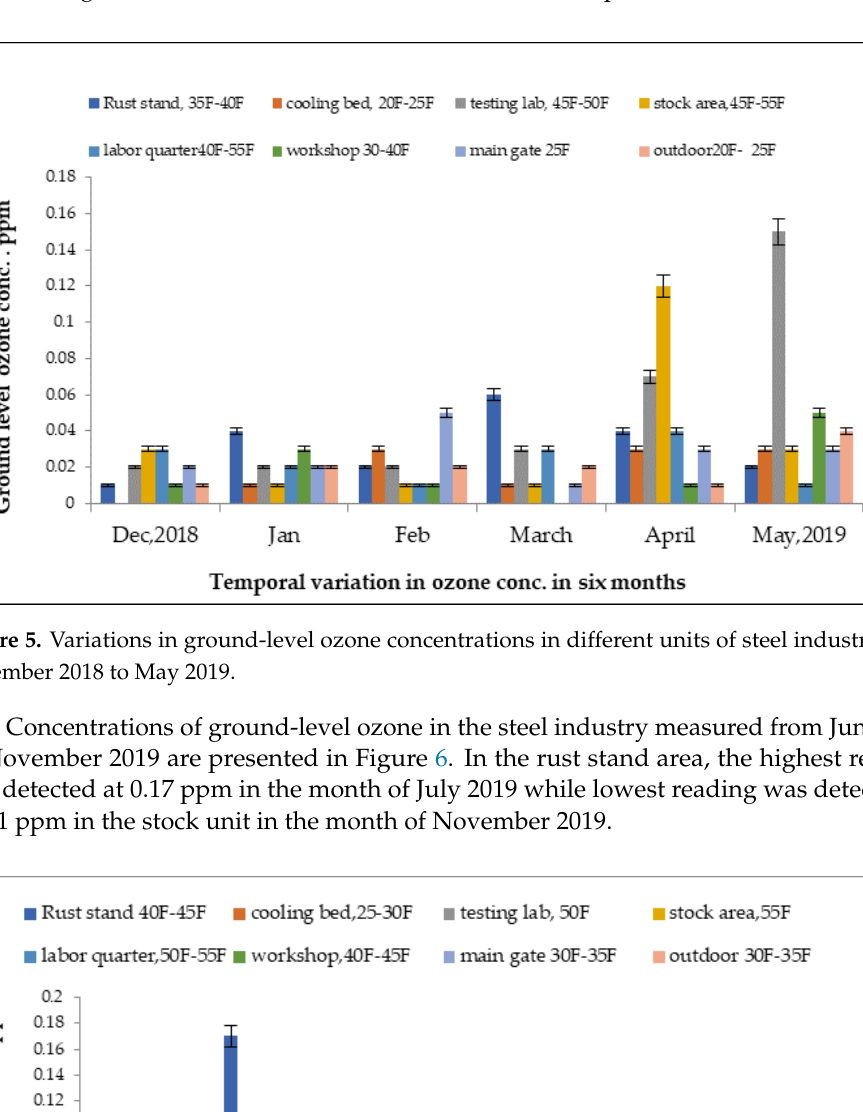
Figure 4. Variations in ground-level ozone concentrations in different units of food industry from